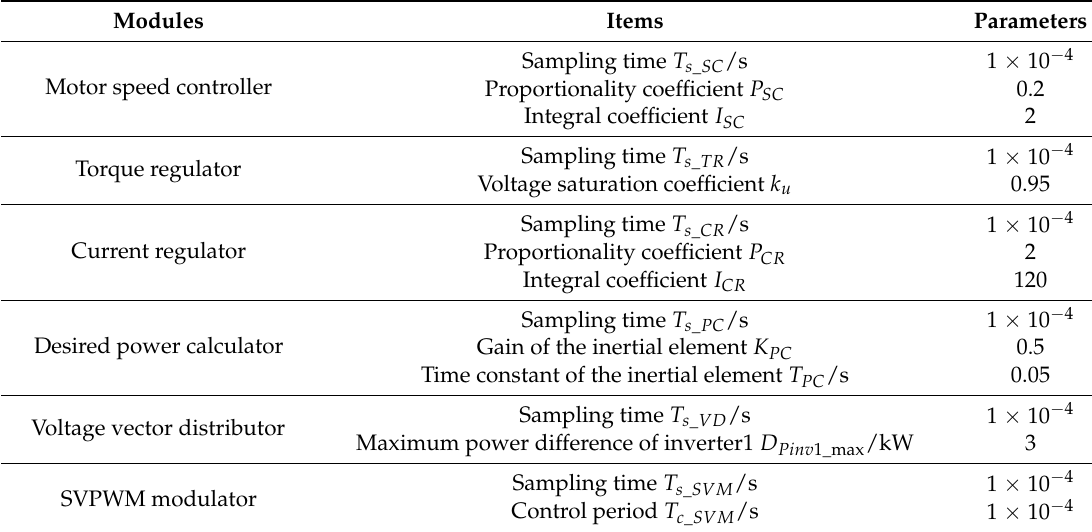
Table 3. Parameters of the drive system controller. SVPWM: space vector pulse width